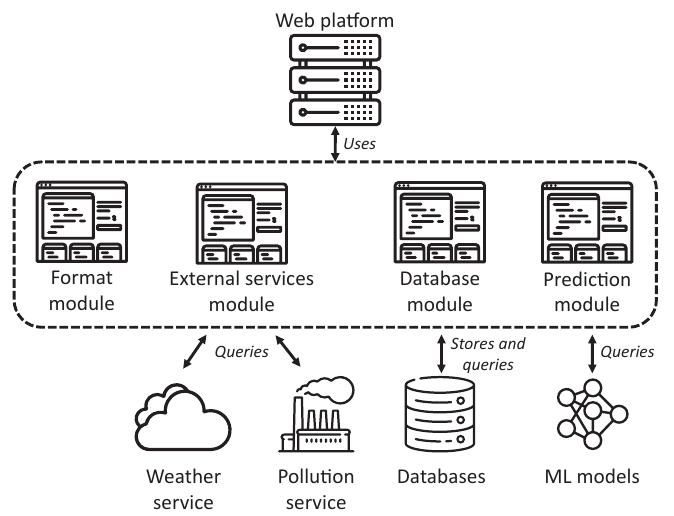
Figure 7. Elements integrating the implemented web